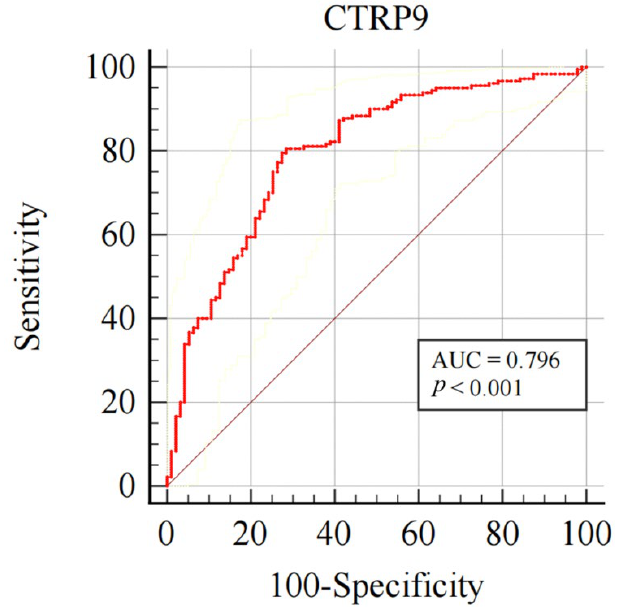
Table 2. Comparison of baseline characteristics between patients with CAC and patients without CAC.